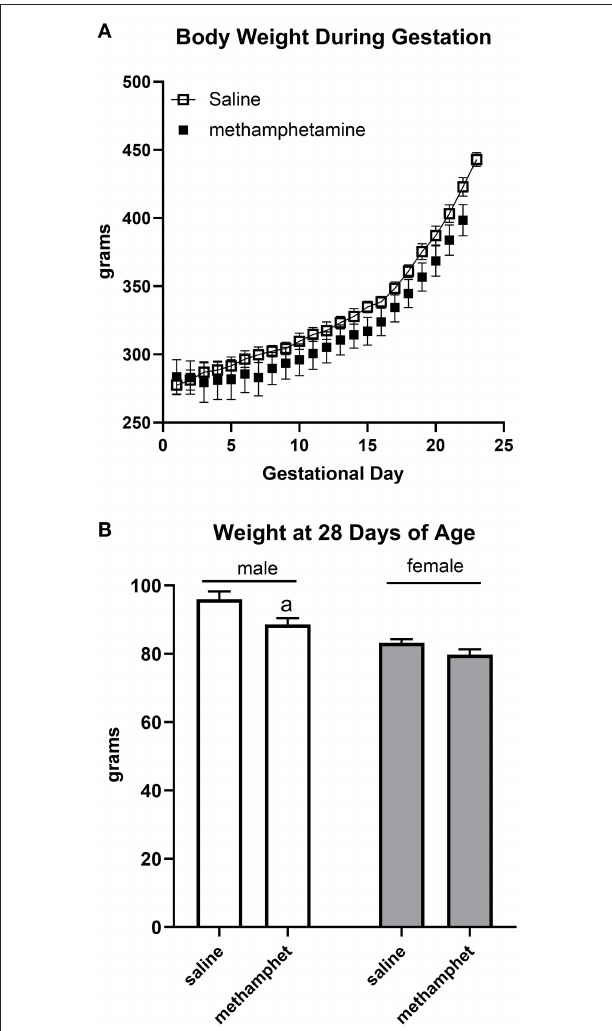
FIGURE 1 | Impact of methamphetamine on gestational weight and body weight of offspring. Pregnant female rats received daily injections of saline ( n = 5) or methamphetamine (5 mg/kg) ( n = 5) starting on gestational day 1 and continuing until the pups were born. Two-way ANOVA indicated a significant effect of time [F = 140 (2, 11), p < 0.0001] but no effect of methamphetamine on gestational body weight. All methamphetamine-treated dams delivered pups on gestational day 22. Three saline treated dams delivered pups on gestational day 22 and two dams delivered on day 23. Data represent the mean ± SEM of 5 pregnant dams in each group (A) . Offspring were weighed at 28 days of age at the time of weaning. Two way ANOVA indicated